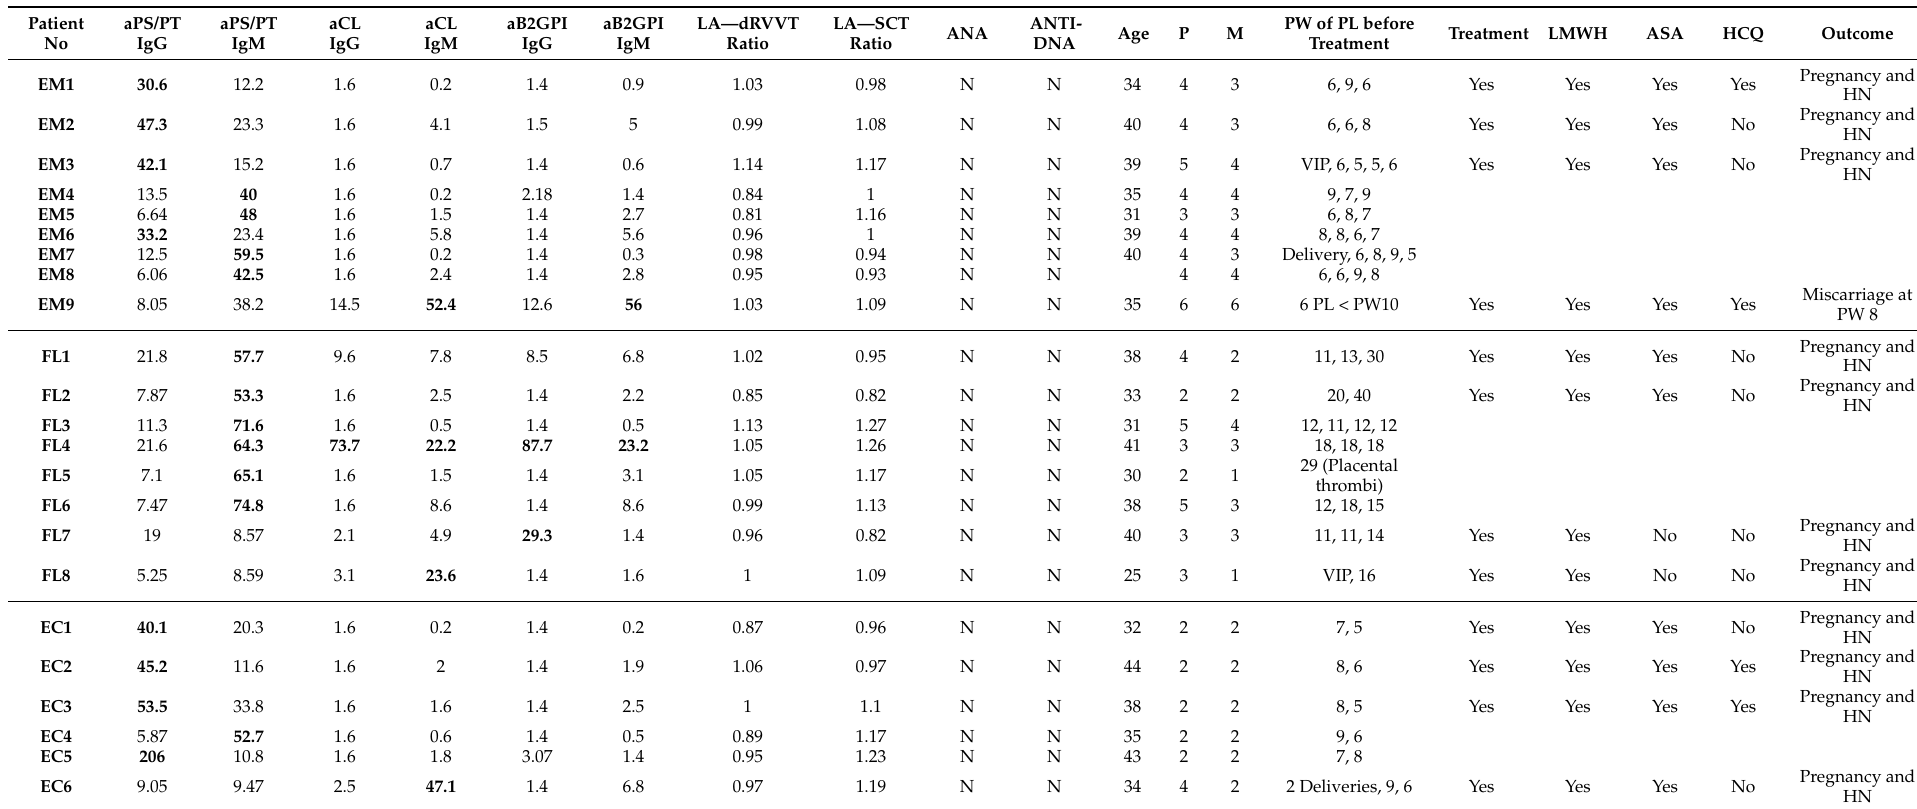
Table 4. Obstetrical history, aPL levels, treatment and outcome of patients carrying positive aPL.